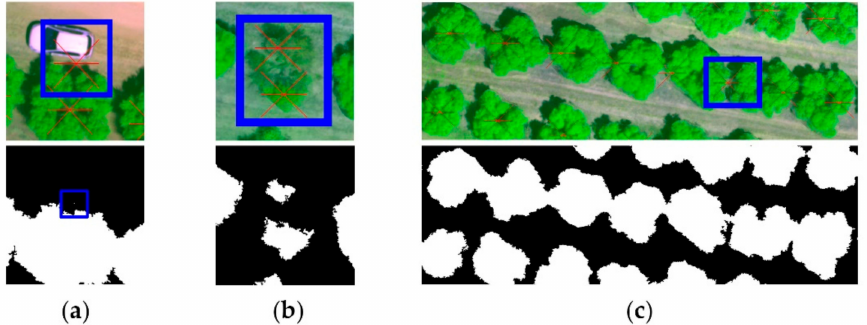
Figure 14. False positives detected during performance assessment: ( a ) case related to a car parked next to the study site; ( b ) case consequence of wrongly splitting one tree into two di ff erent connected components because of its damaged condition; ( c ) case obtained after overestimating the number of trees contained in an aggregated connected